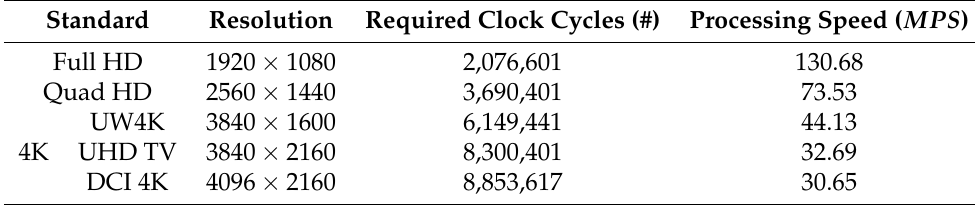
Table 4. Maximum processing speeds in frames per second for different image resolutions. The sym- bol # denotes